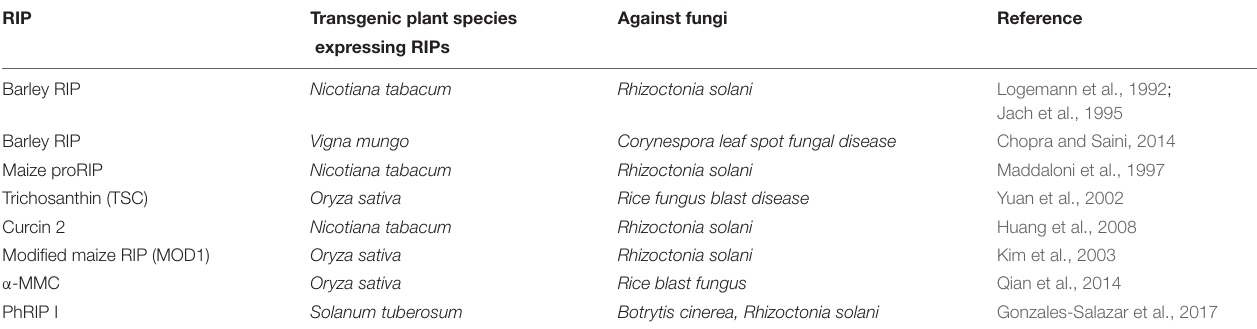
TABLE 3 | Transgenic plant species expressing RIPs show enhanced resistance to fungi